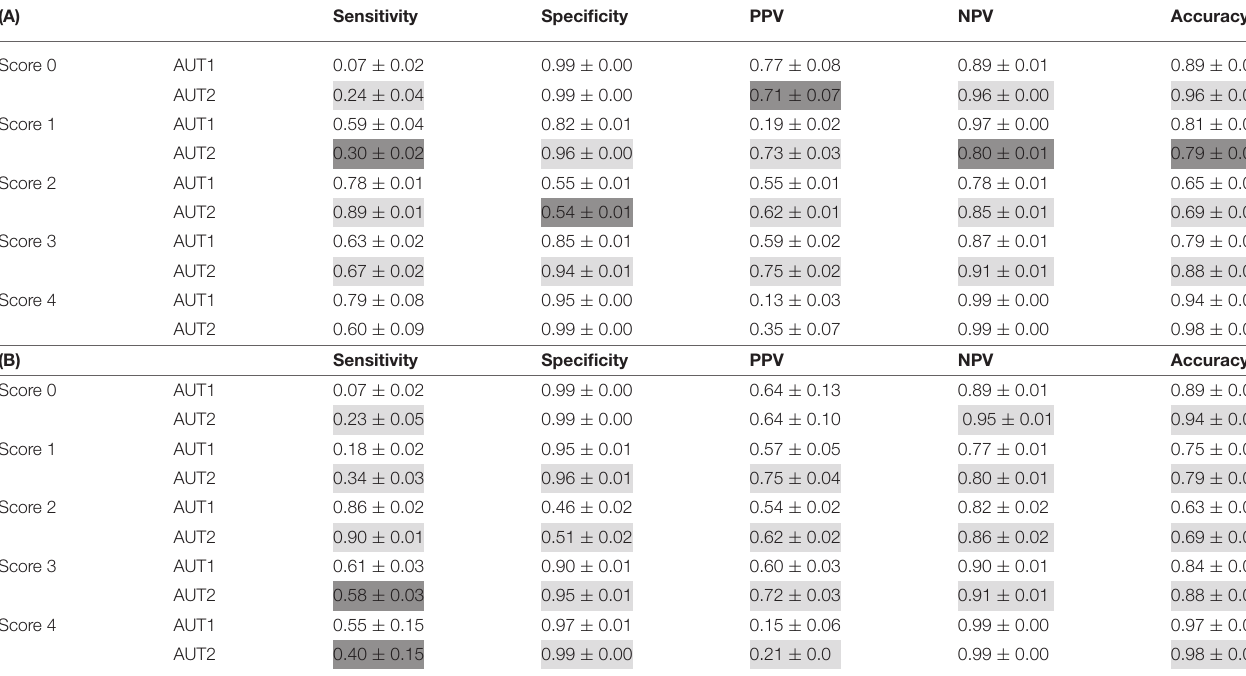
TABLE 4 | Performance of the automated scoring system (A): Full dataset (pre-modification: n = 2,646; post-modification n = 2,510); (B): Small dataset with only those feet which were scored by both algorithms (AUT1 and AUT2), n = 1,135. (A)